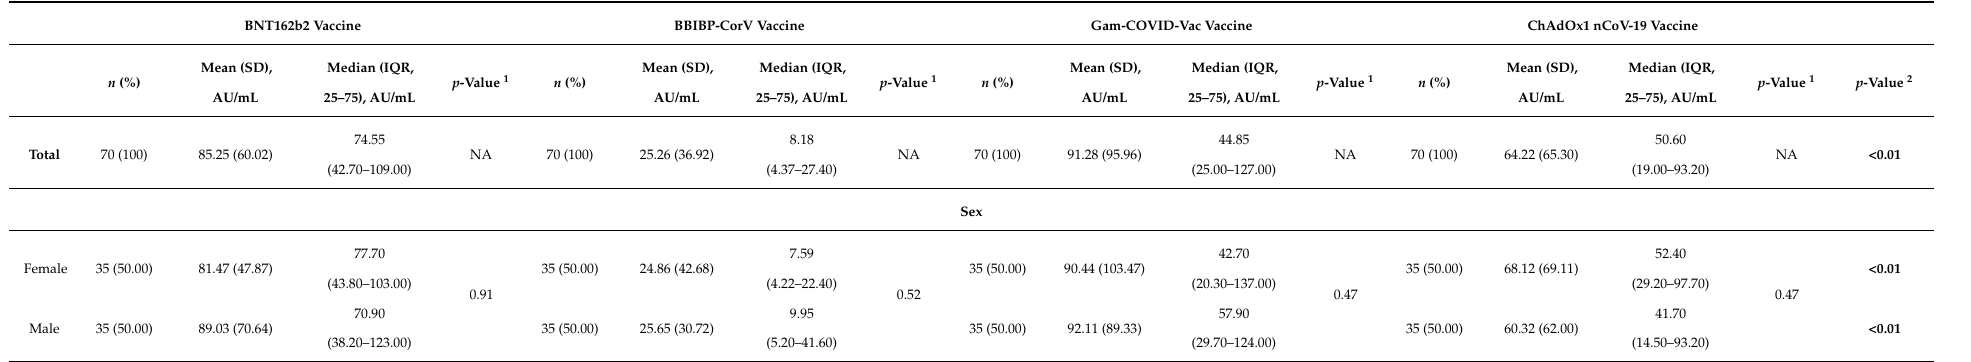
Table 3. Antibody levels at 6 months from the administration of the second dose of vaccine, stratified by sex and age of